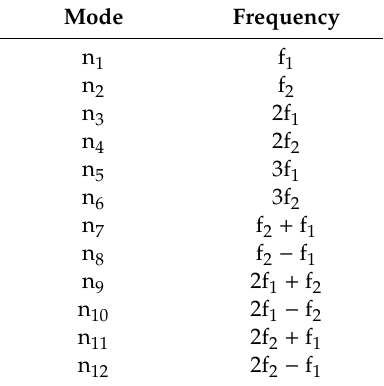
Table 1. Summary